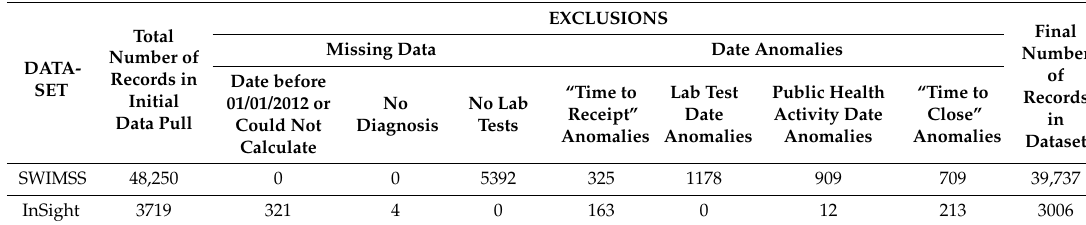
Table 1. SWIMSS and InSight data quality